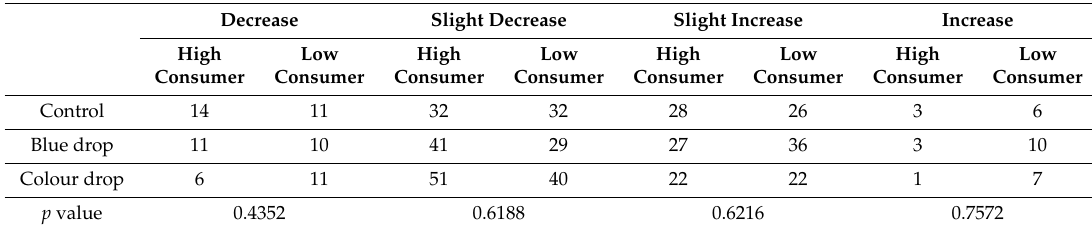
Table 3. Low and high consumers of each group for each cluster and the result of statistical analysis.